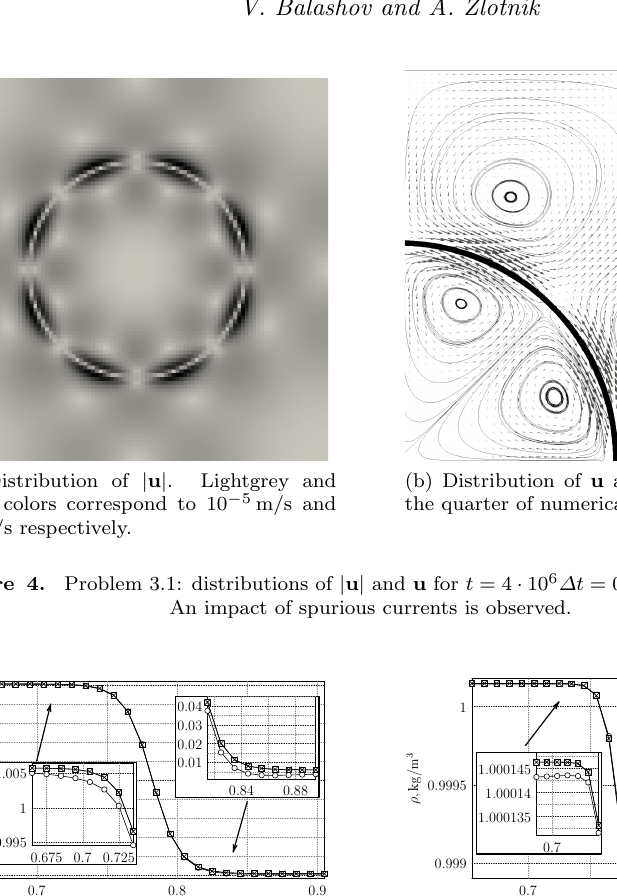
10 6 ∆t = 0 . 19s. The symbols (cid:3) , · schemes A , B and C